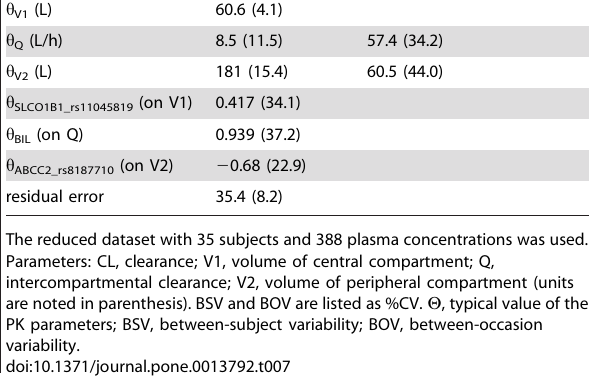
Figure 3. Uptake of flavopiridol, flavo-G, SN-38 and lenalido- mide in OATP1B1 transfected cells. The bar graph indicates means + SD for triplicate determinations of 10 m M flavopiridol, flavo-G, SN-38 and lenalidomide uptake rates in cell lines (HEK-293 or MDCK-II) transfected with empty control vector or vector cloned with the OATP1B1 gene (SCLO1B1). Incubations with flavo-G were for 30 min., and all other drugs were for 10 min. Transport rates are expressed as percentages normalized to empty vector control. * p , .05, **